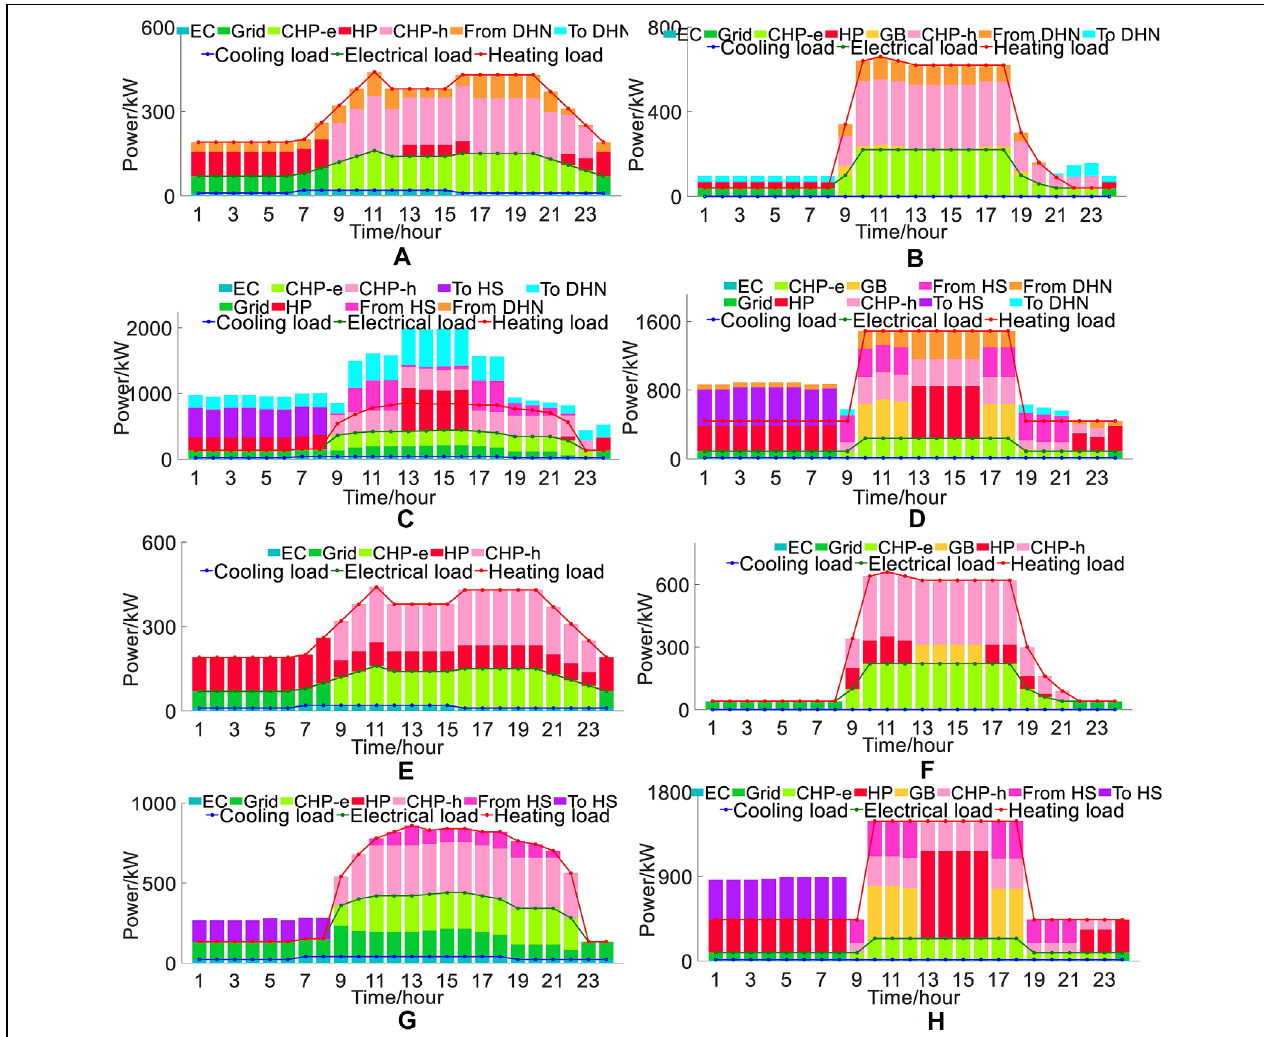
FIGURE 11 | Energy components of the EHs in scenario A and B. (A) Energy components of EH1 in scenario A. (B) Energy components of EH2 in scenario A. (C) Energy components of EH3 in scenario A. (D) Energy components of EH4 in scenario A. (E) Energy components of EH1 in scenario B. (F) Energy components of EH2 in scenario B. (G) Energy components of EH3 in scenario B. (H) Energy components of EH4 in scenario B.